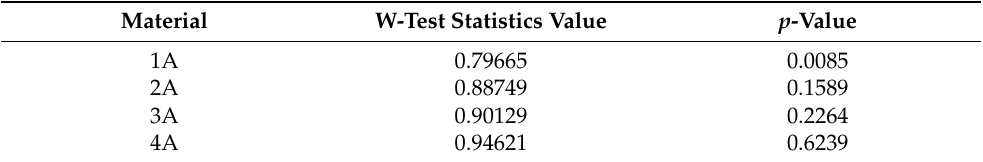
Table 13. S-W test results for individual materials.